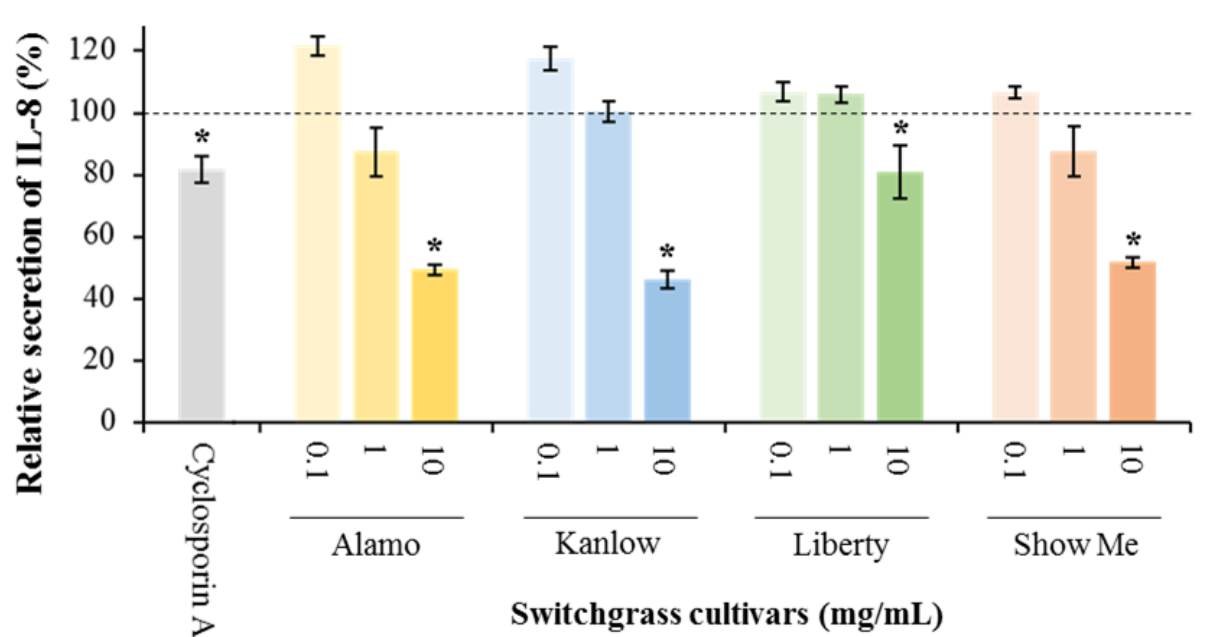
Figure 2. Effect of the switchgrass extracts on the expression of IL-6 in the U-937 model system. (*) Significant decrease ( p < 0.01) compared to the control cells without the extract. Mean ± SEM.